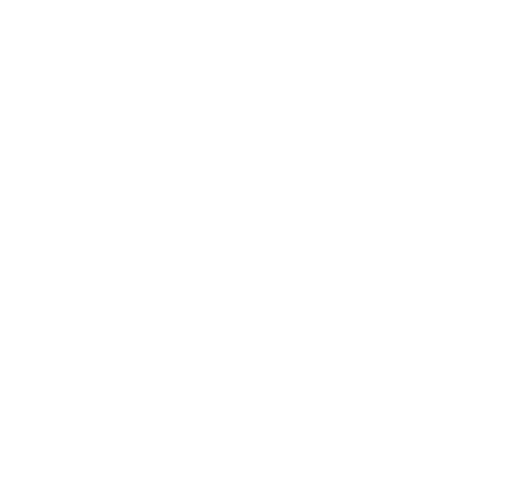
Figure 16. Relation graph between direction relation semantic expression and angle